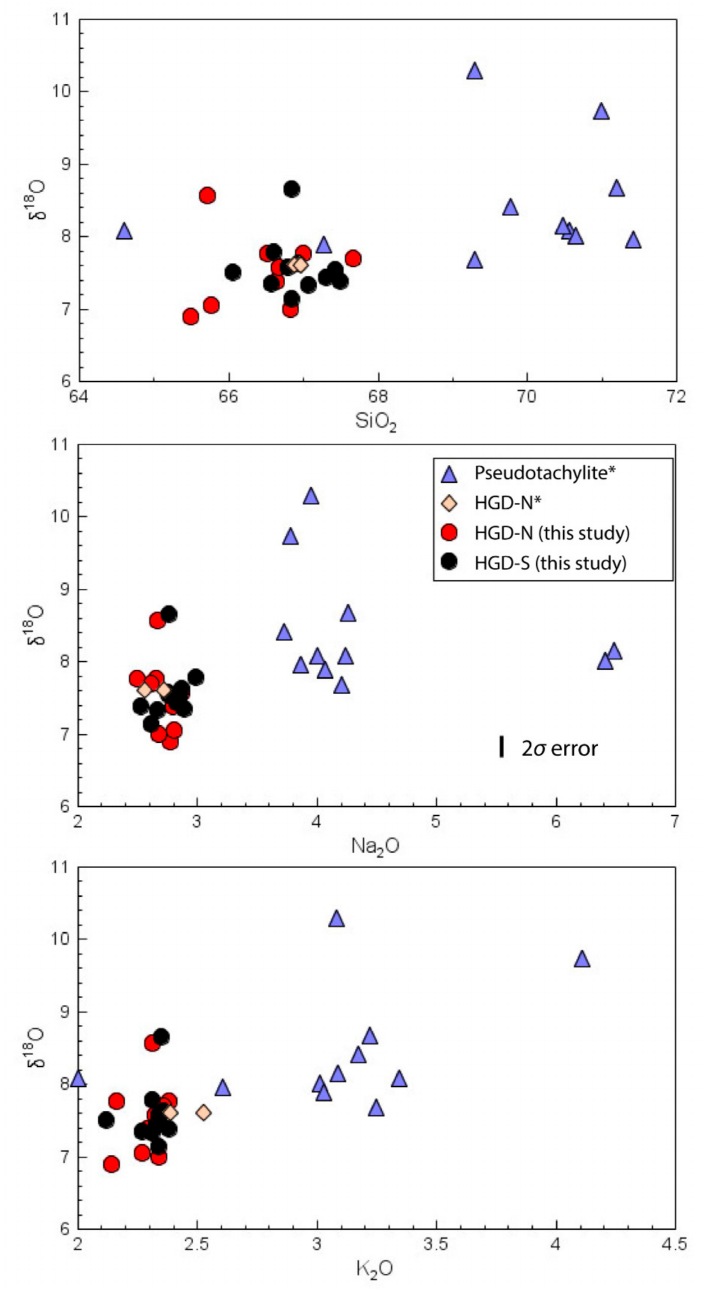
Figure 14. Plots of the δ 18 O value vs. SiO 2 , Na 2 O, and K 2 O for granophyre samples. * Data points for HGD-N* and pseudotachylite veins from the Vredefort Impact Structure from